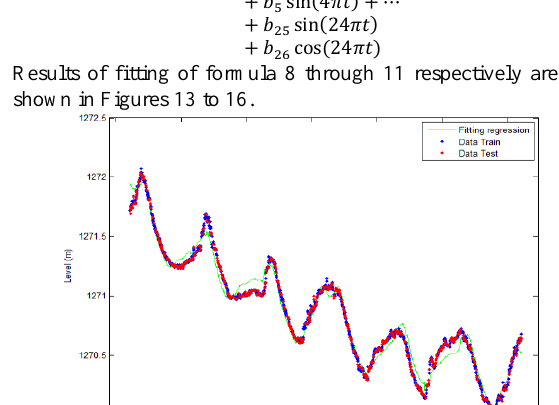
Figure 13: The regression graph of 1 st degree polynomial + periodic behavior